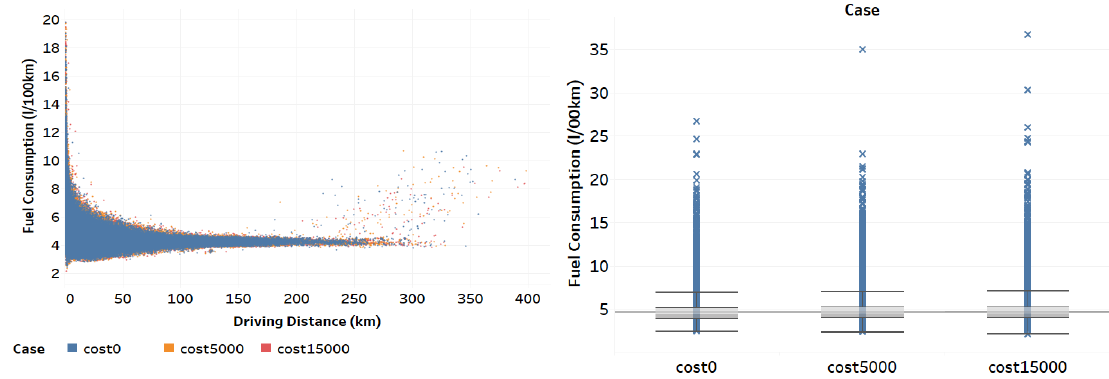
Figure 4. Fuel consumption distribution of conventional vehicles.